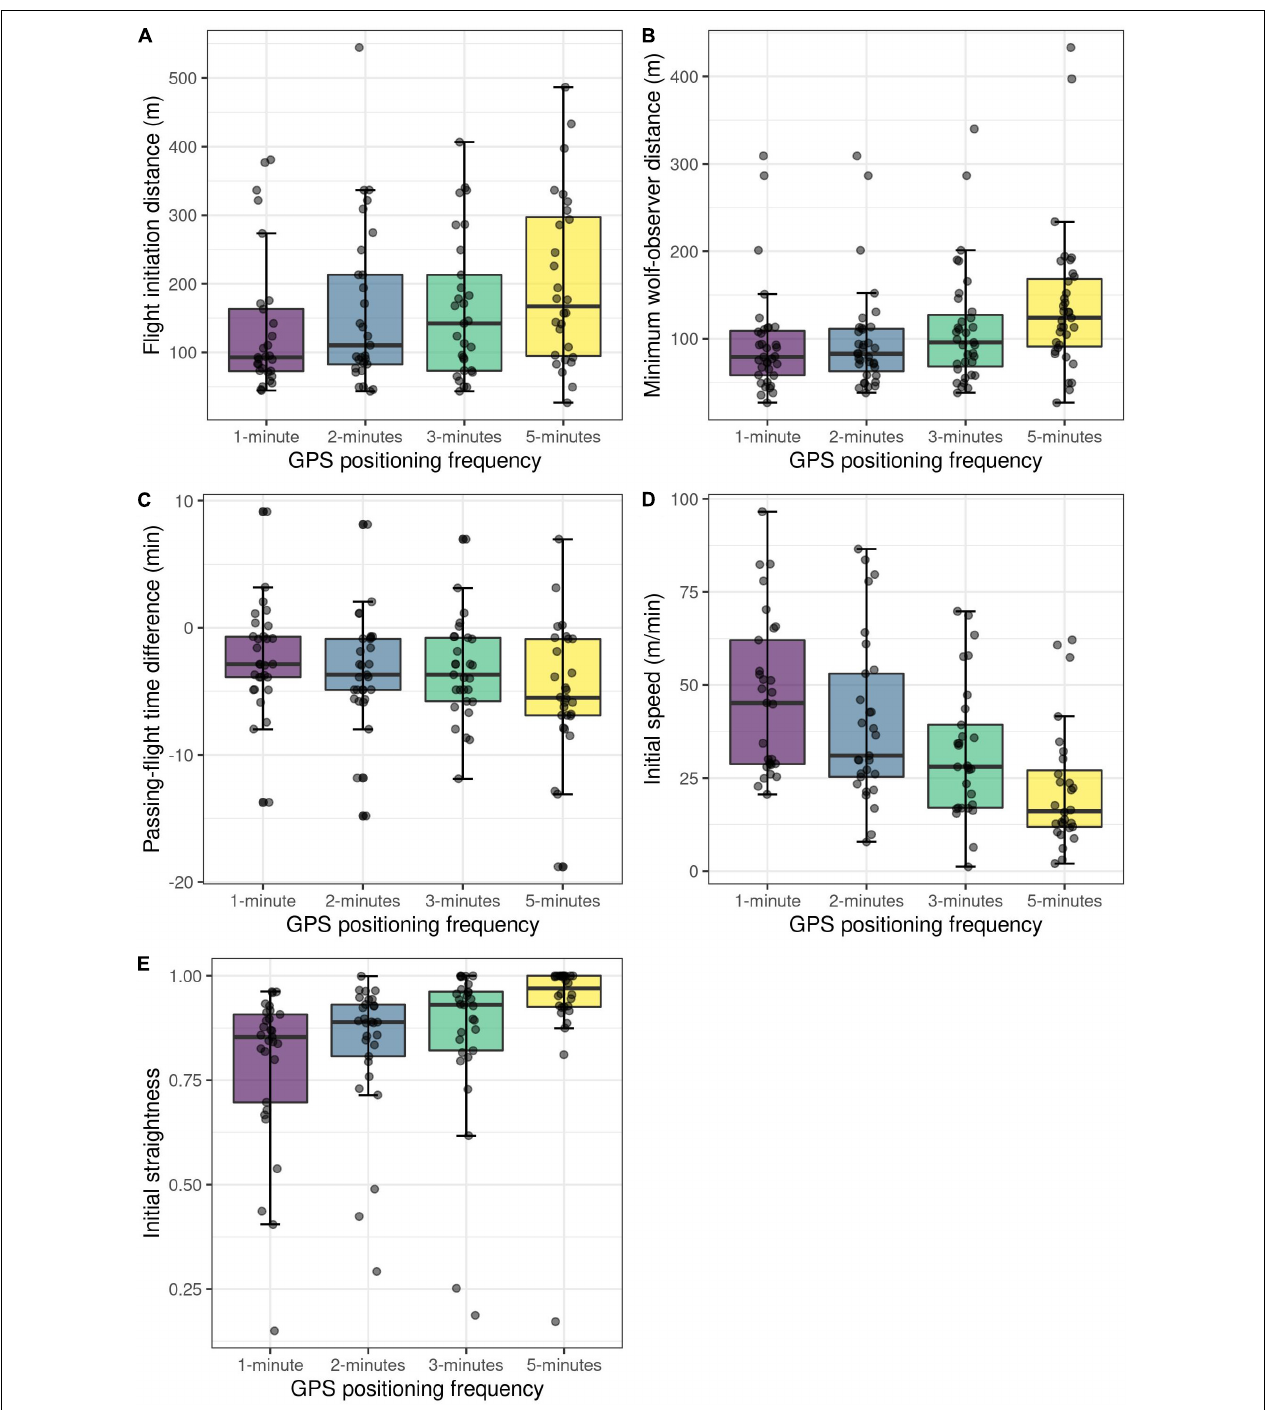
FIGURE 5 | Comparison of five different wolf response variables (A–E) from experimental human approach trials, calculated with varying GPS positioning frequency. Variables were calculated from data from the first 10 min after flight initiation.